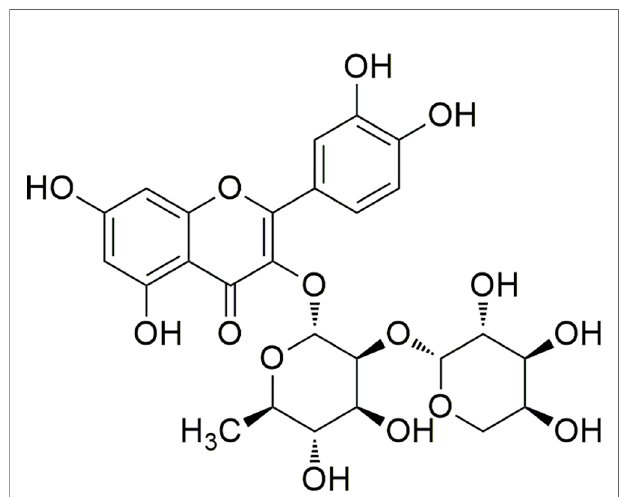
FIGURE 1 | Structure of compound